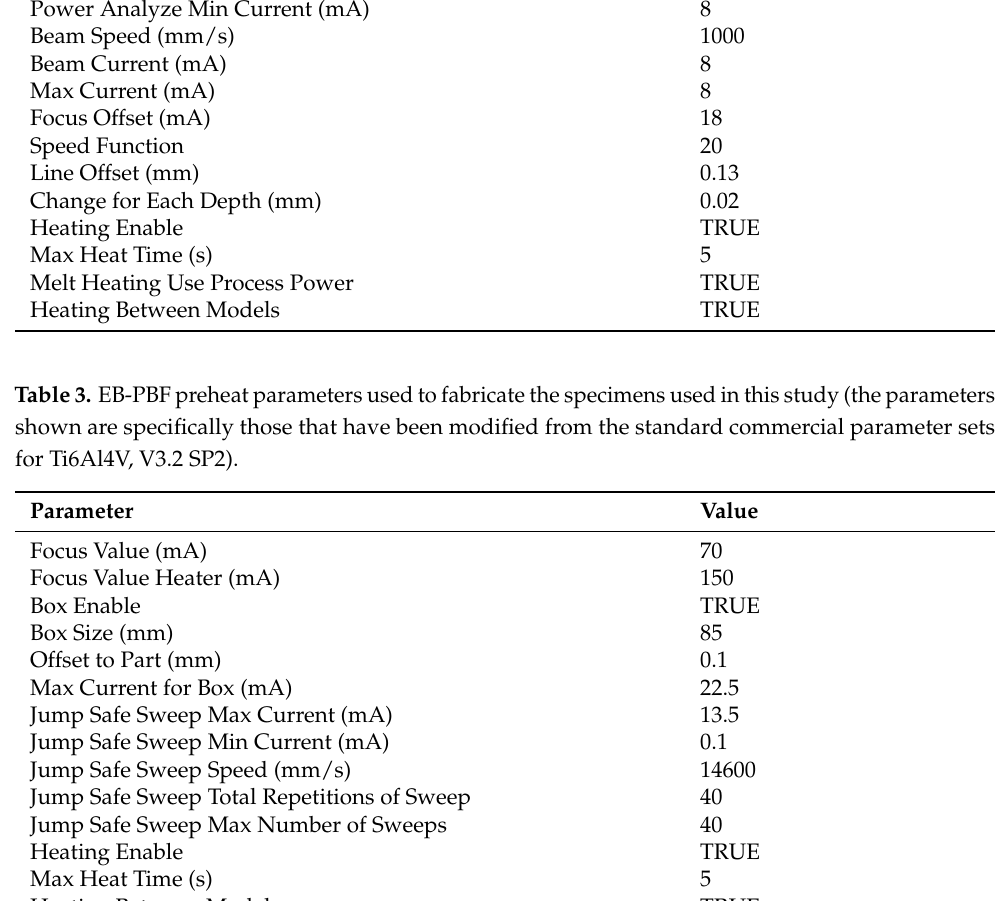
Table 2. EB-PBF melt parameters used to fabricate the specimens used in this study (the parameters shown are specifically those that have been modified from the standard commercial parameter sets for Ti6Al4V, V3.2 SP2).